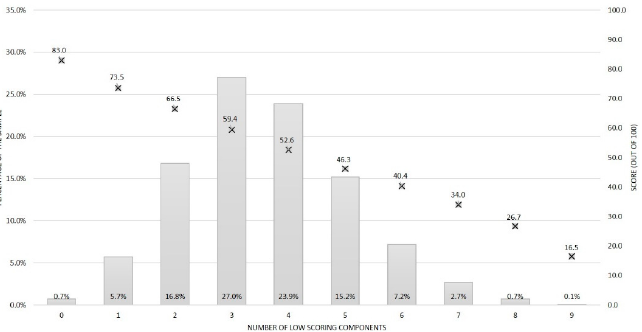
Figure 2. Distribution of the number of low scoring components within the dietary guideline index (bars) and total diet score (crosses) across the sample.